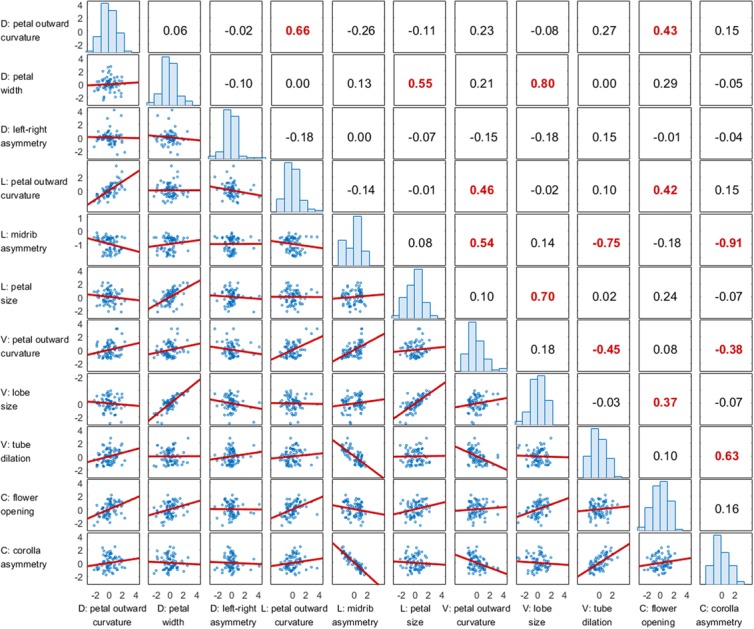
Correlation matrix of the defined traits. The numbers at the upper triangle indicate the correlation coefficients, and the P-values less than 0.005 are highlighted in red. The figures at the lower triangle indicate the correlation plots. The figures at the diagonal indicate the distributions of the defined traits. D, V, and L denote the dorsal, ventral, and lateral petals, respectively. C denotes the corolla.